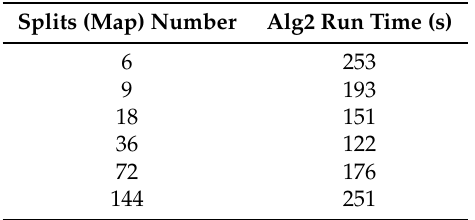
Table 6. The impact of split number on algorithm